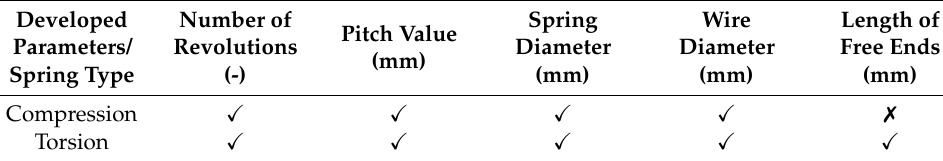
Table 1. Compression and torsion spring design parameters.